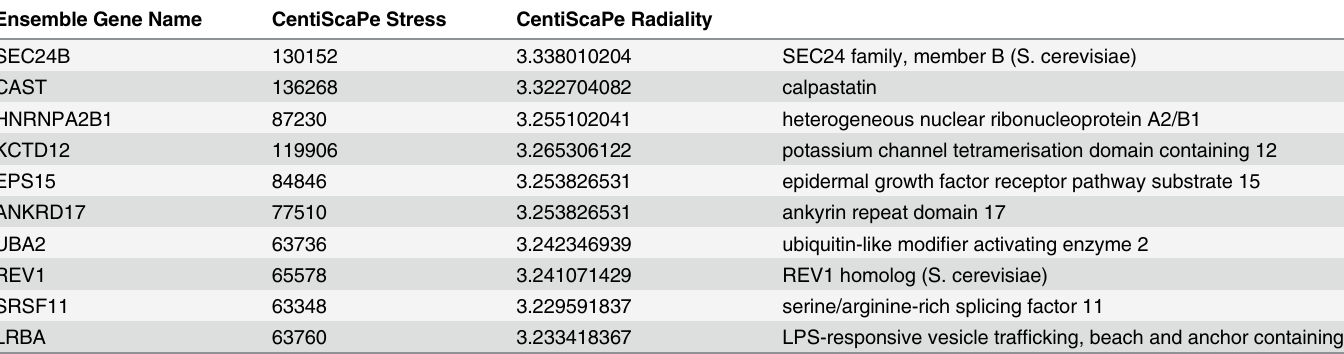
Table 3. Top ten most highly related nodes in network of downregulated genes. Ensemble Gene Name